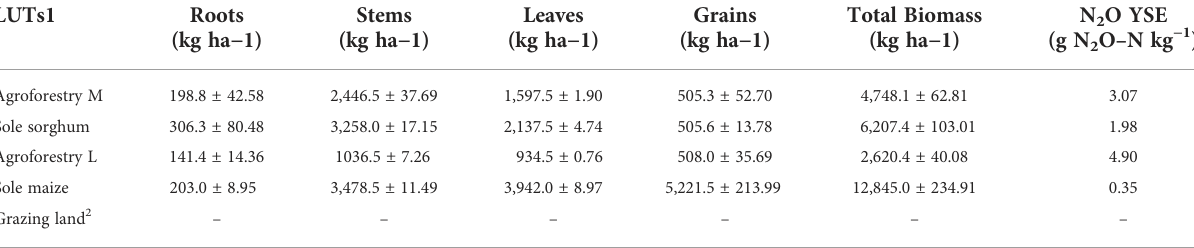
TABLE 5 Maize and sorghum production under different land utilization types during the SR 20 in Siaya County, Kenya.